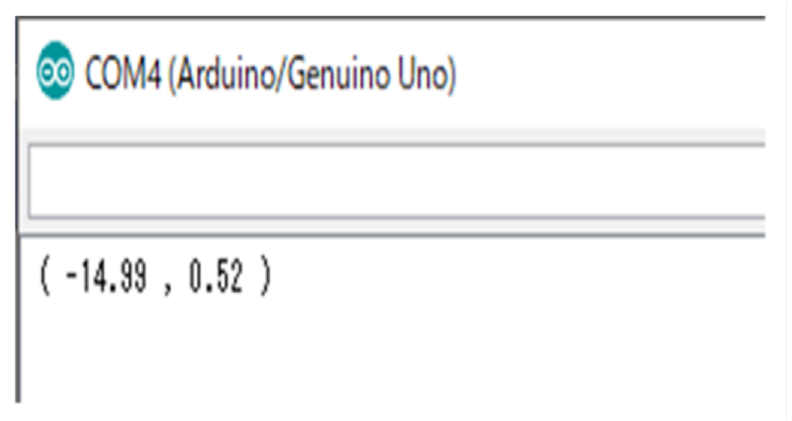
Figure 14. Robot’s own coordinate calculation results.